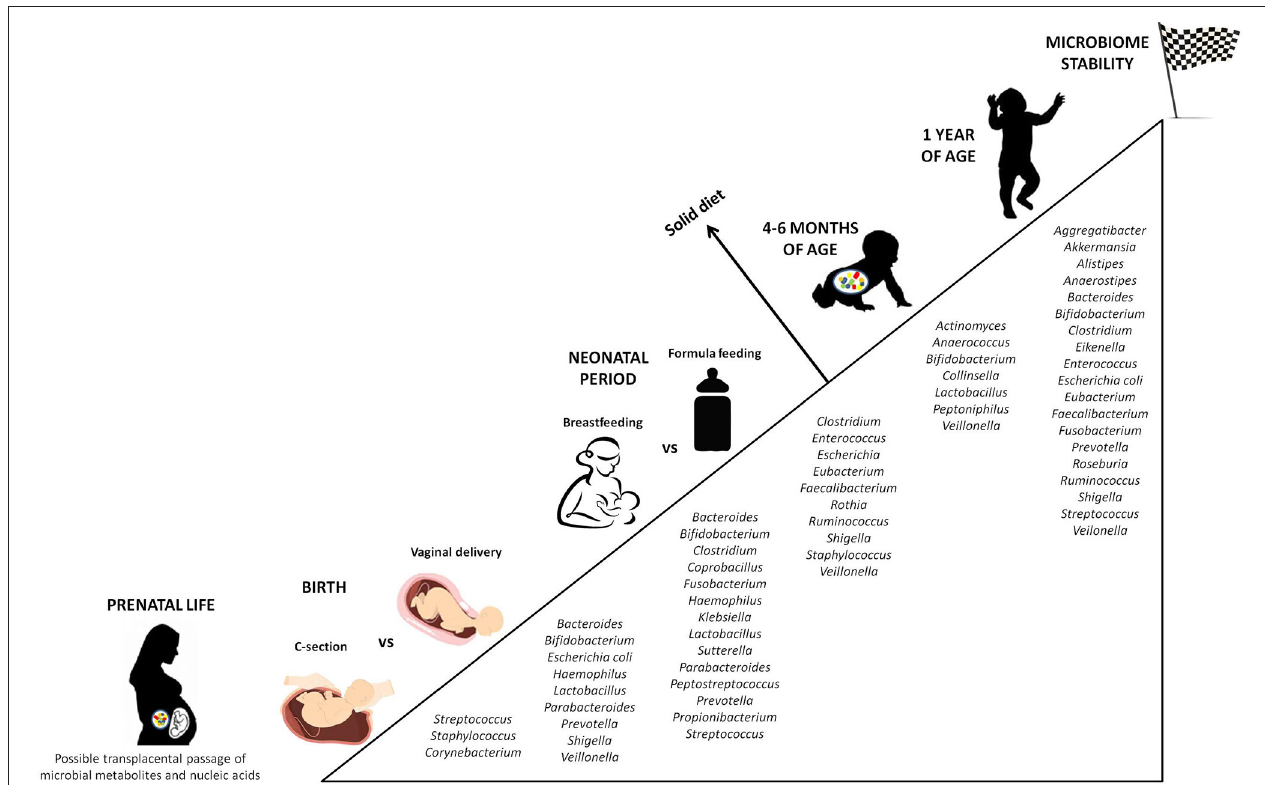
FIGURE 2 | Progressive colonization of the gut mucosa by bacterial species. The figure displays the major microbial species colonizing the intestine from prenatal life to early childhood, highlighting the differences according to external factors able to influence the microbial composition (C-section vs. vaginal delivery, breastfeeding vs. formula feeding). Stability of the microbial ecosystem is reached around 1 year of age, when the child microbiota has become similar to the maternal one. An additional influencing role is played by the diet in the first months of life. Not surprisingly, the introduction of solid food causes a significant change in the intestinal microbial